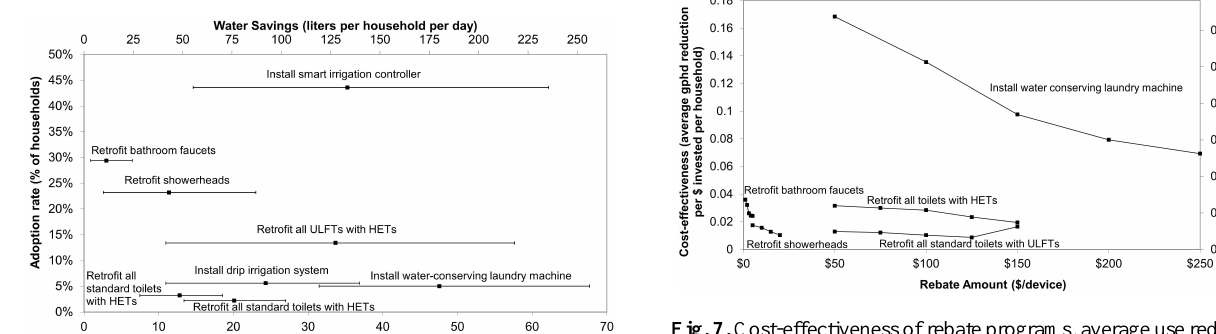
Fig. 7. Cost-effectiveness of rebate programs, average use reduction per rebate dollar invested by the utility per